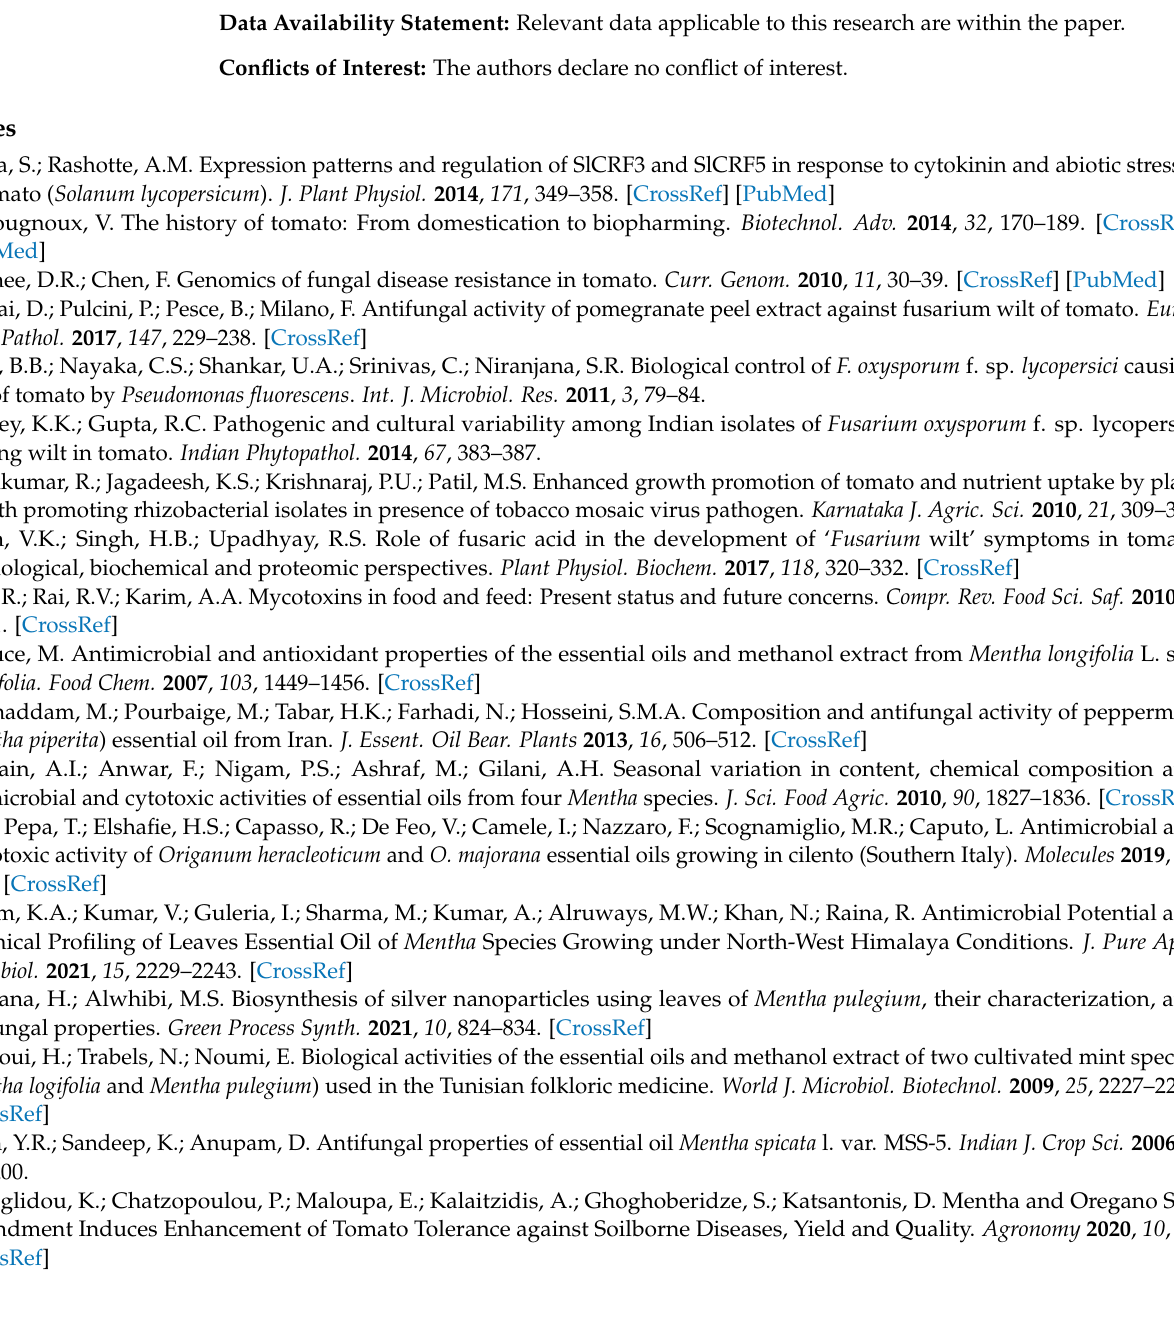
Figure S6. Relative expression level of defensin gene in S. lycopersicum seedling under Fusarium inoculation and application of M. spicata and M. longifolia EOs. Different letters indicate significant differences between different treatments at p ≤